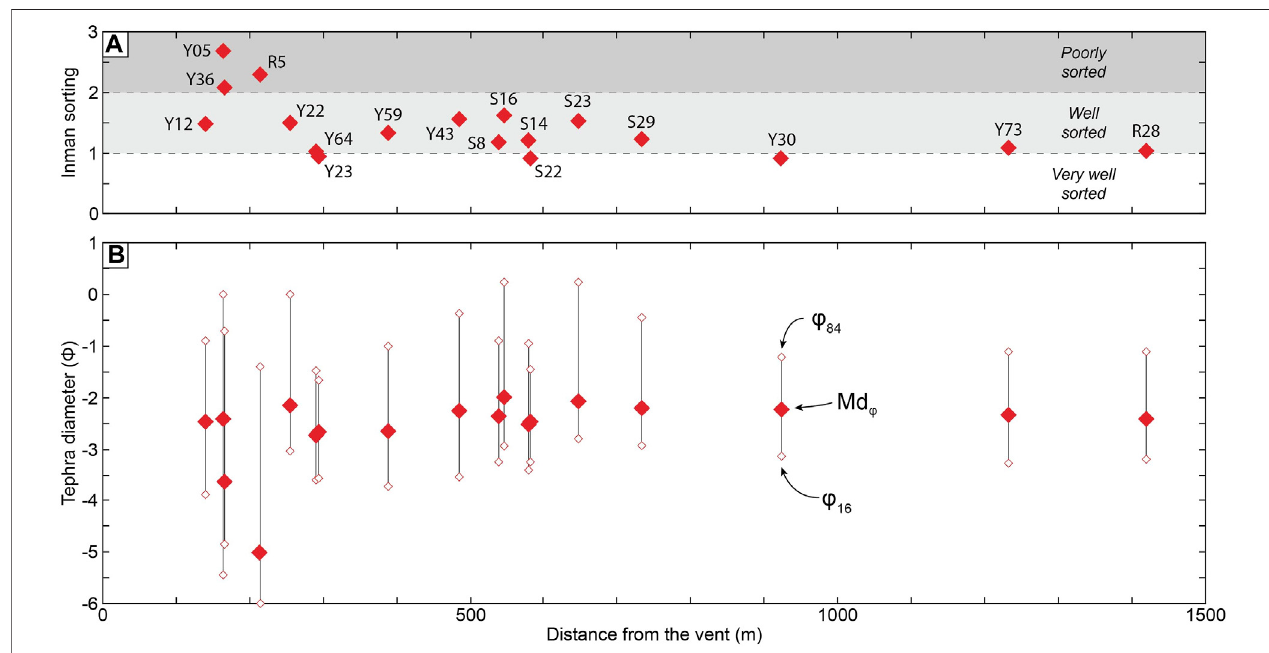
FIGURE 6 | Grain size analyses on 18 Tseax tephra samples collected between 140 and 1,420 m from the main inner tephra cone. A Inman sorting parameter (A) and tephra diameter ( Φ ) (B) plotted against distance from the vent. Md φ : median diameter; φ 16 and φ 84 : 16th and 84th percentiles, respectively.